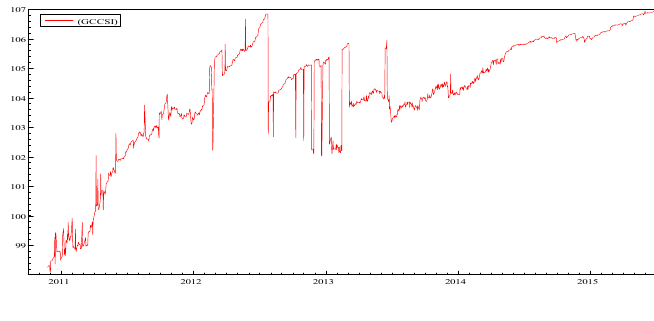
Figure 2. Price dynamics of GCCSI.